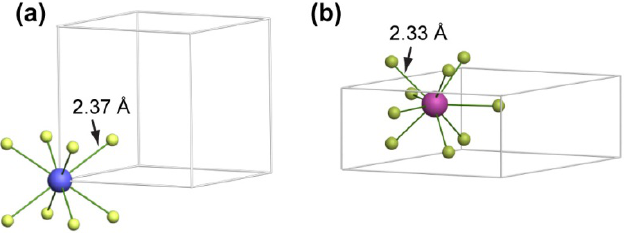
Figure 1. A comparison of the crystal site for the metal ions in the ( a ) cubic and ( b ) hexagonal phase NaYF 4